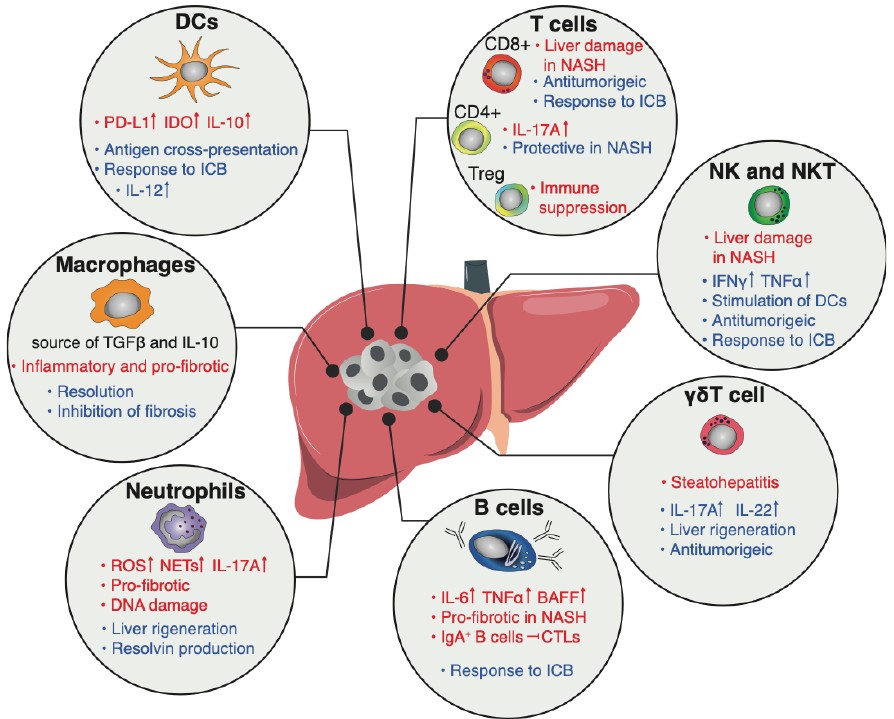
Figure 1. The immune landscape of the HCC microenvironment. A schematic illustration depicting the tumor-promoting (red) and tumor-inhibitory (blue) functions of the most abundant tumor- infiltrating